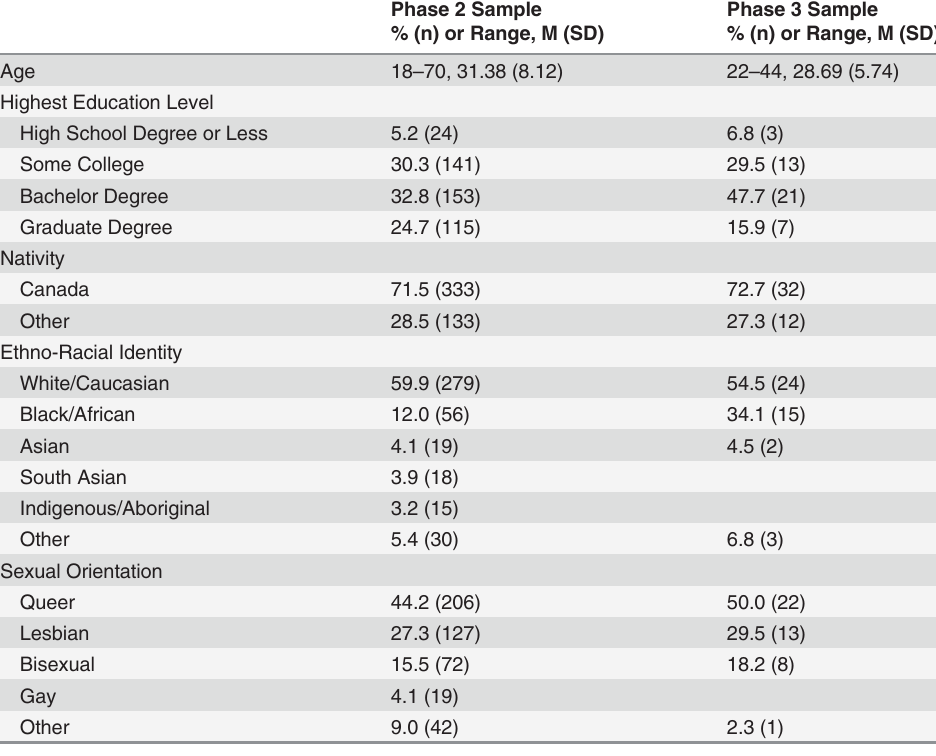
Table 1. Demographic characteristics of lesbian, bisexual and queer women participants in an online survey (n = 466) and STI intervention (n = 44) in Toronto,